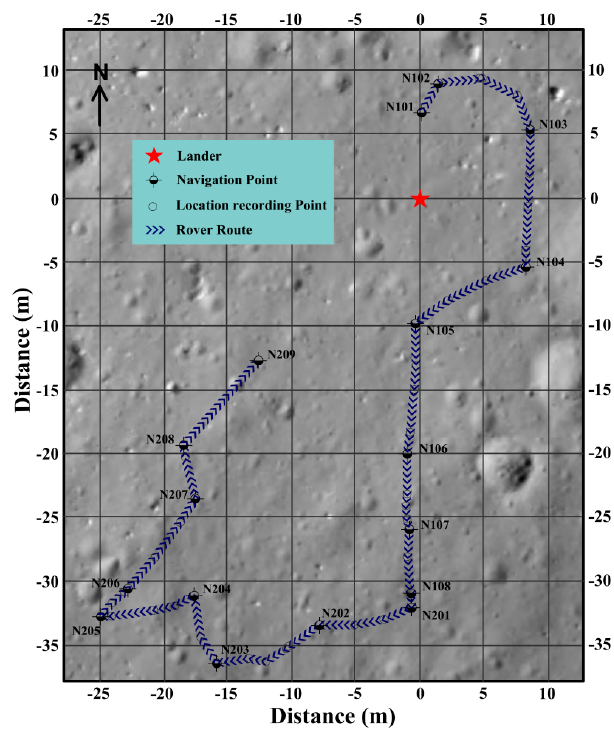
Figure 1. Yutu’s path on the Moon. The context image was taken by the descent camera on the CE-3 lander. The red star shows the landing site. The blue line shows the path.